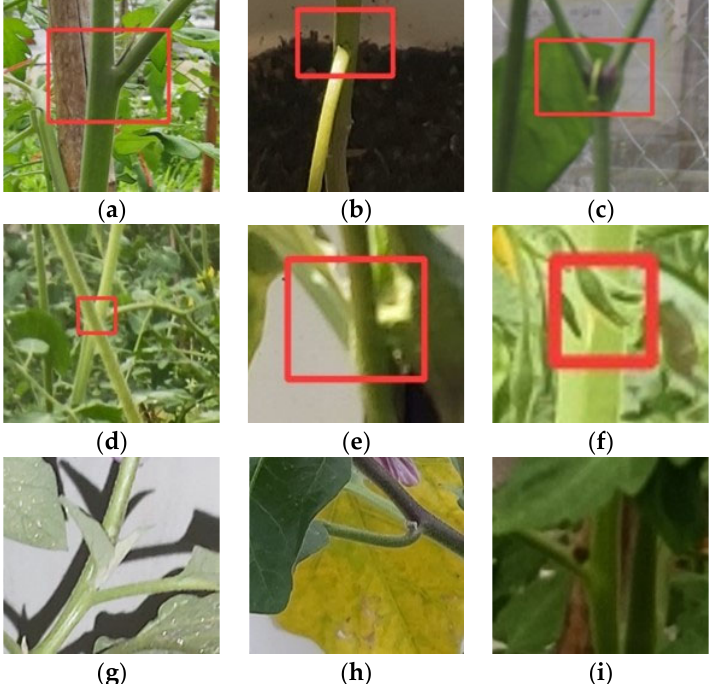
Figure 11. Examples of detected and undetected nodes. ( a – c ) True positives; ( d – f ) false positives; ( g – i ) false negatives.